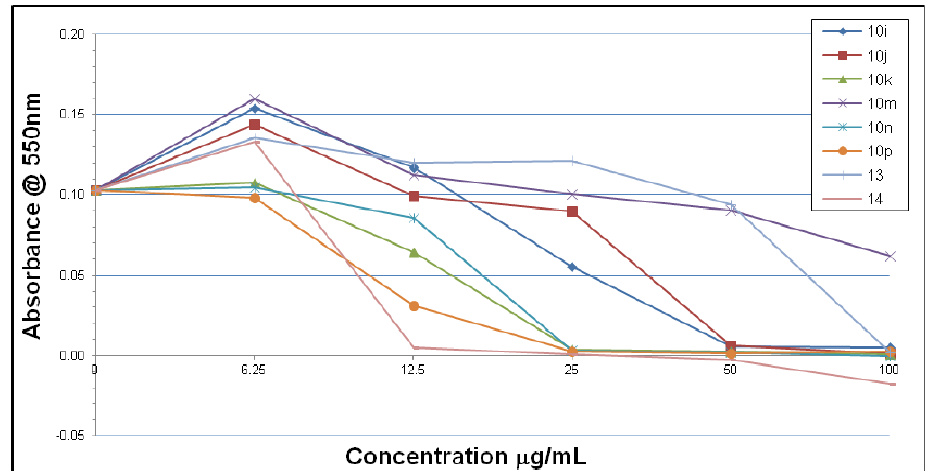
Figure 4. Inhibitory effects of compounds 10i – p , 13 and 14 on H. pylori 26695 after 7